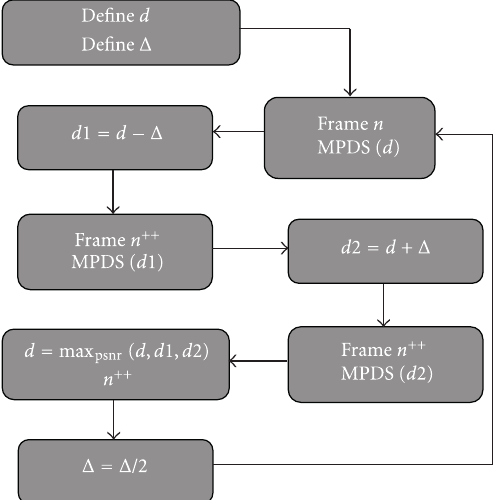
Figure 7: Dynamic control of the d parameter in the DMPDS